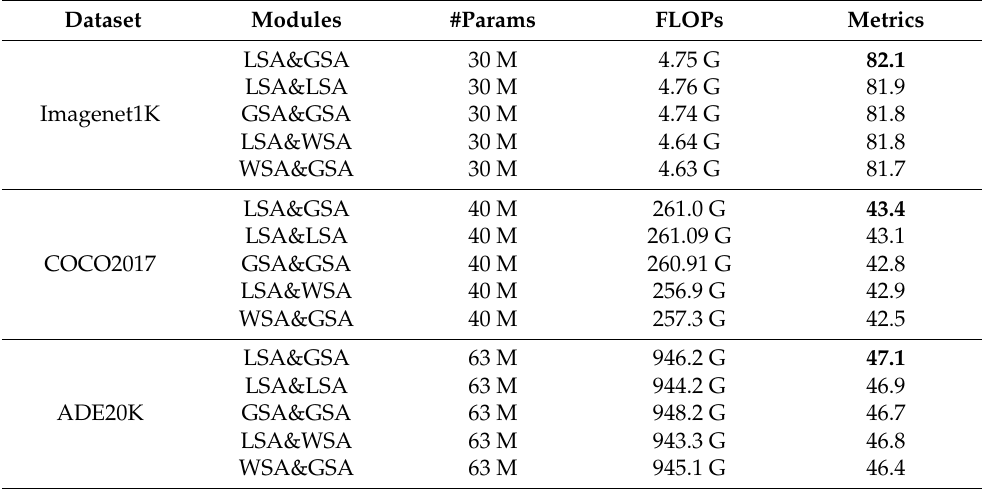
Table A1. Quantitative results of using different self-attention modules. WSA means the original Window-based self-attention proposed in